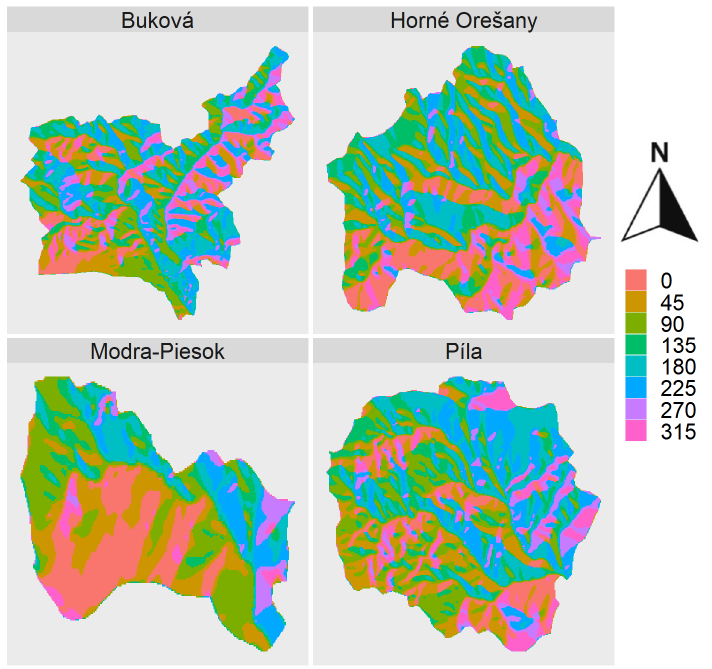
Figure 7. GIS analysis of the slope aspect of the catchments under consideration.